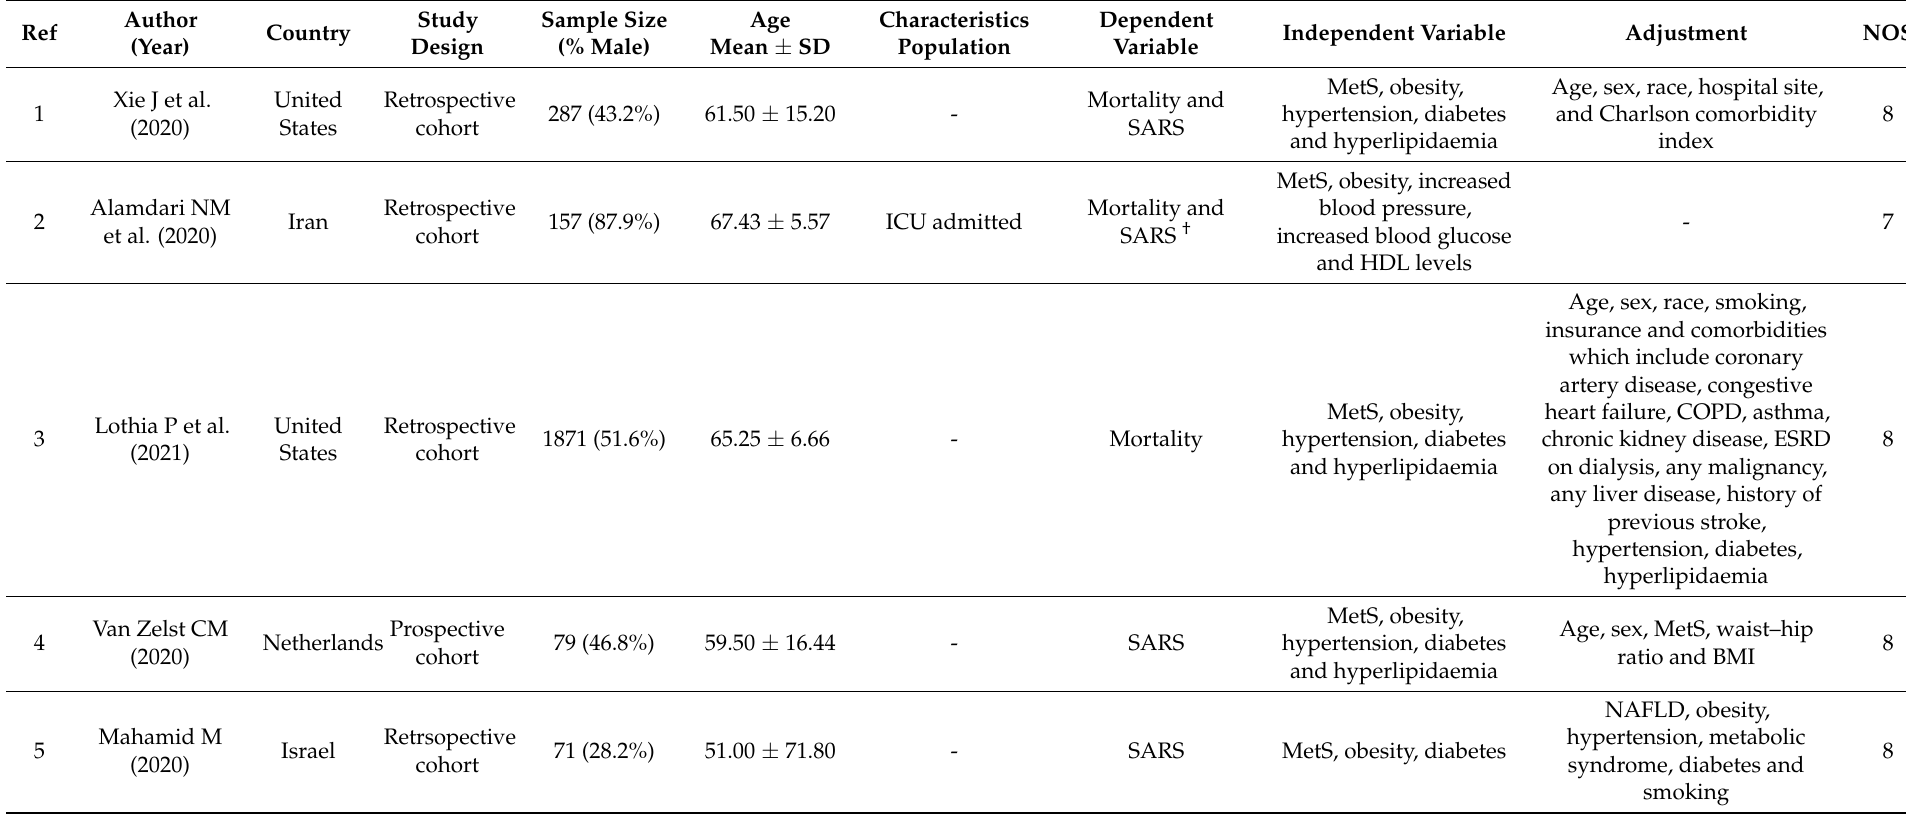
Table 1. Basic characteristics of the studies included in the